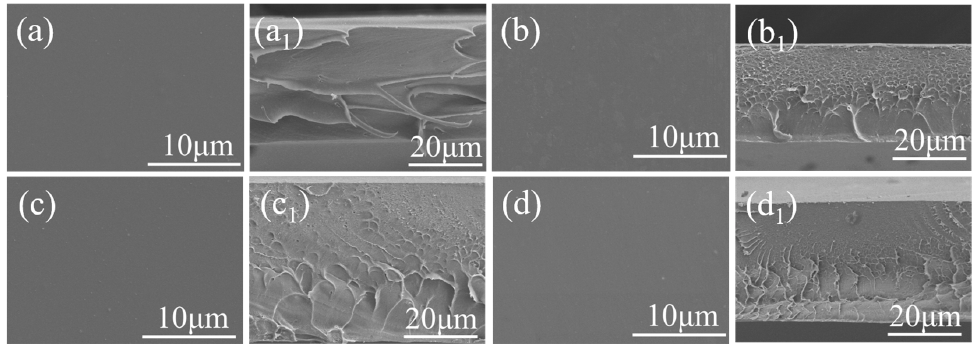
Figure 4. Surface and section morphology of COPBI-0 ( a , a 1 ), COPBI-5 ( b , b 1 ), COPBI-10 ( c , c 1 ), and COPBI-20 ( d , d 1 ).